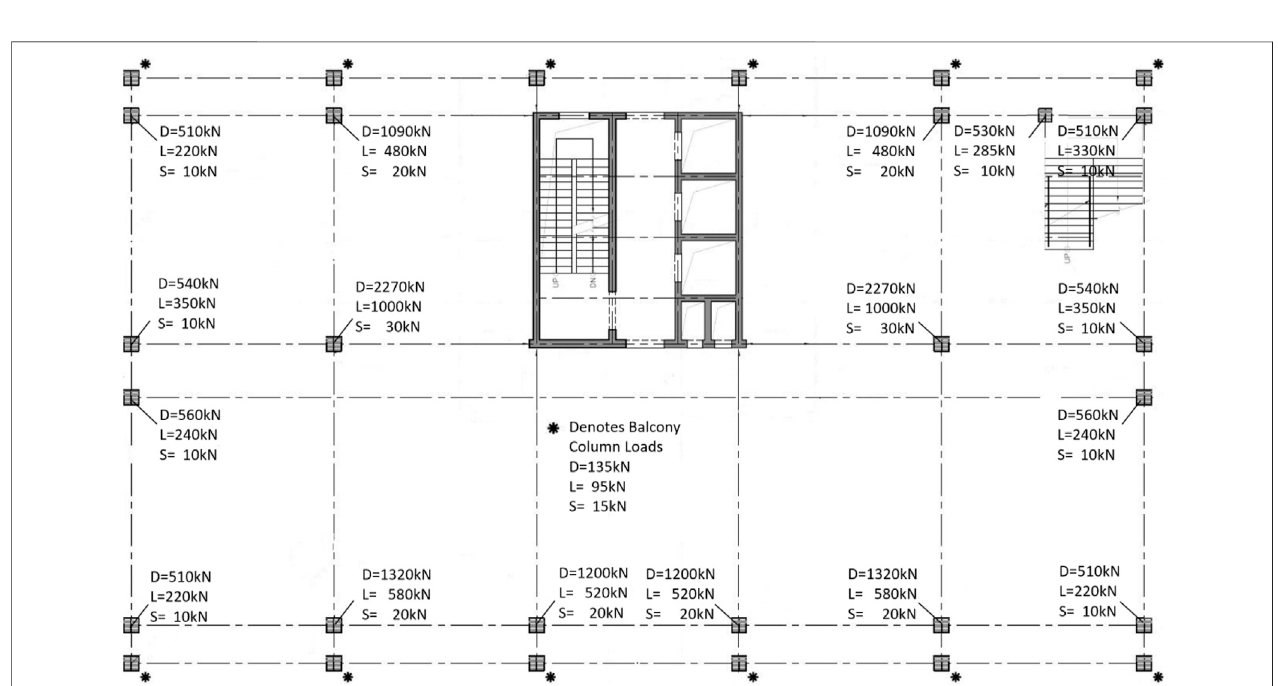
FIGURE 6 | Design loads for glulam